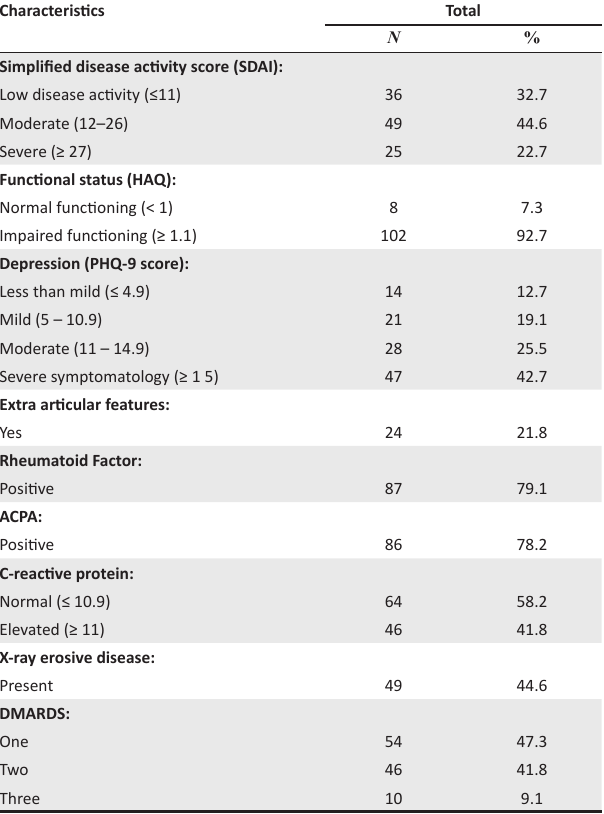
TABLE 2: Rheumatoid arthritis disease activity profile in rheumatoid arthritis participants. Characteristics